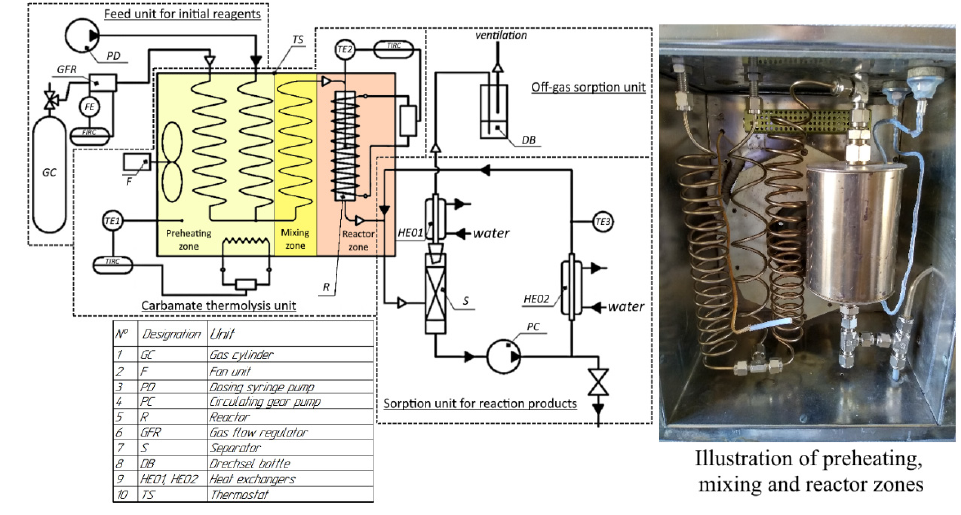
Figure 3. Diagram of a laboratory facility for carbamate thermolysis.